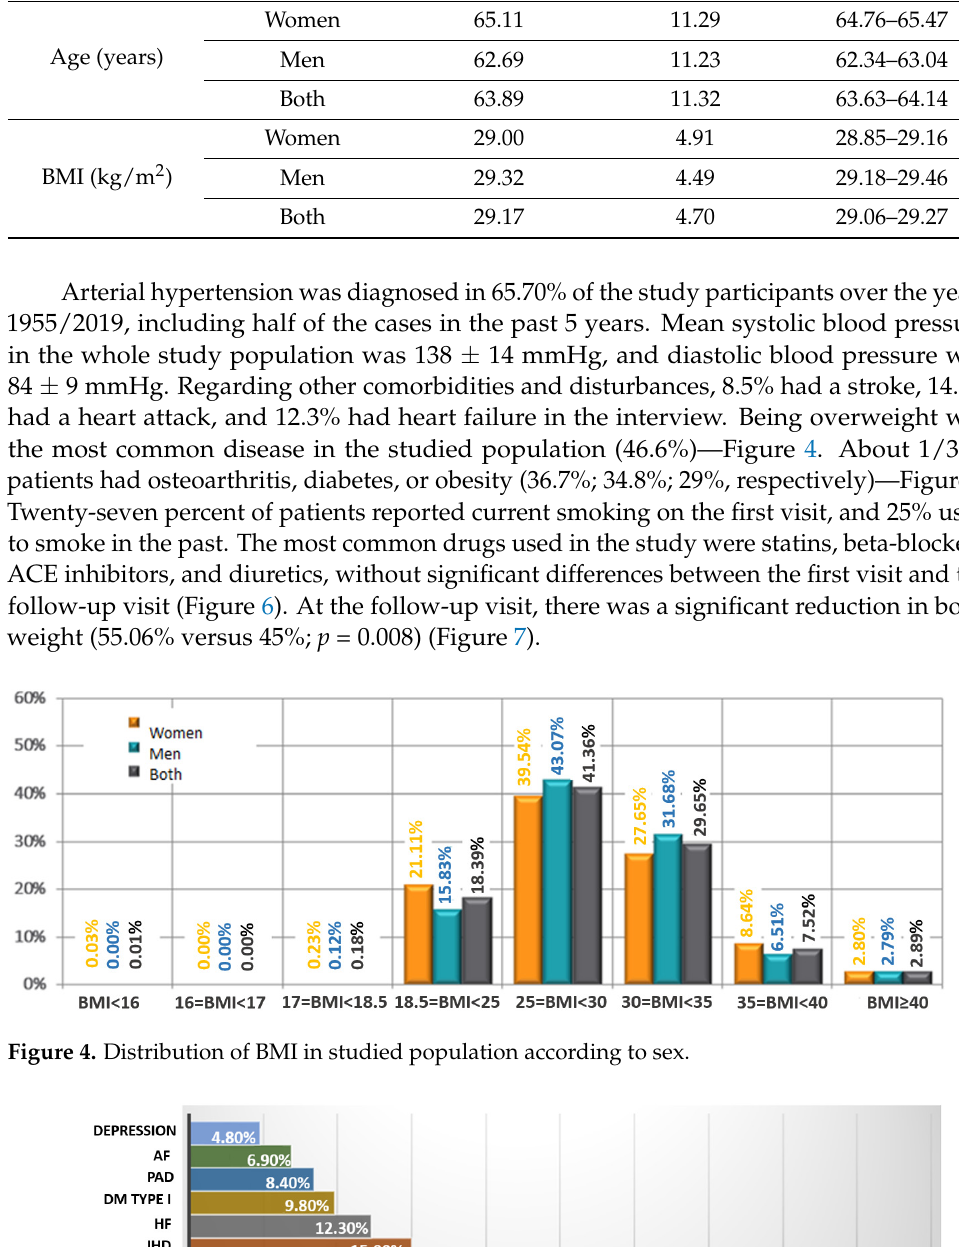
Figure 6. Pharmacotherapy in studied population (visit 1–visit 2) (BB—beta-blockers; ACE-I—angi- otensinconverting enzyme inhibitor; IPP — inhibitor of proton pomp; CCB—calcium channel block- ers; H2B—H2 receptor blockers; bl.—blockers). Figure 7. Change in body weight in studied population according to gender (visit 1–visit 2). There was also observed a reduction in peripheral arterial pressure, both systolic (138 ± 14 versus 132 ± 11 mmHg; p < 0.001) and diastolic (80 ± 8 mmHg vs. 84 ± 10; p < 0.001)— Figure 8.